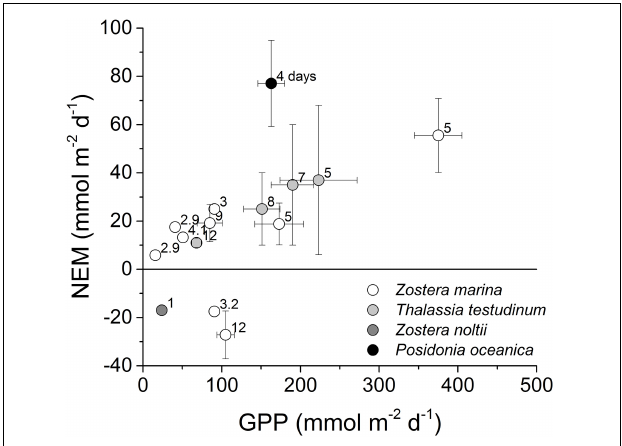
FIGURE 7 | Across-study comparison of spring and summer (March through August) seagrass ecosystem metabolism determined with aquatic eddy covariance. Labels indicate days of measurement. To evaluate autotrophy, net ecosystem metabolism (NEM) is presented as a function of gross primary production (GPP; ± s.e.). Literature sources for Z. marina : Hume et al. (2011), Rheuban et al. (2014a), Attard et al. (2019), and Berg et al. (2019); Z. noltii : Lee et al. (2017); T. testudinum : Long et al. (2015b); P. oceanica : this study.